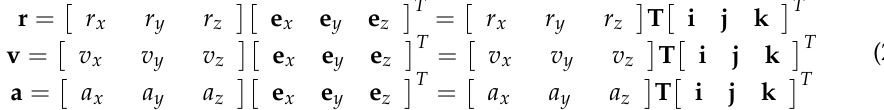
The three rotational angles can be calculated at any instant in the simulation process in which the endpoints of the straight cable element are frequently updated. Correspond- ingly, the nodal position vector r , velocity vector v , and acceleration vector a of an arbi- trary point in a local coordinate system can be expressed in a global system, respectively.